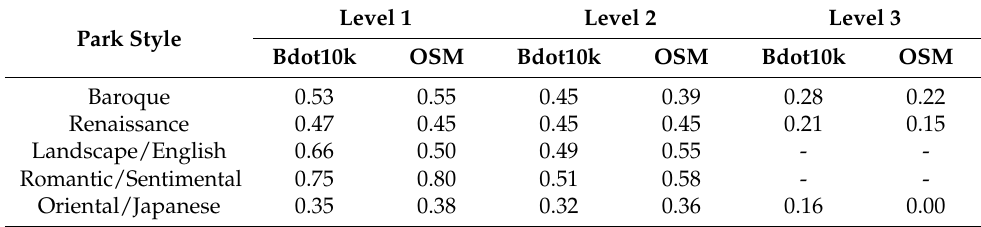
Table 4. DUI values for individual park styles, for three levels of map